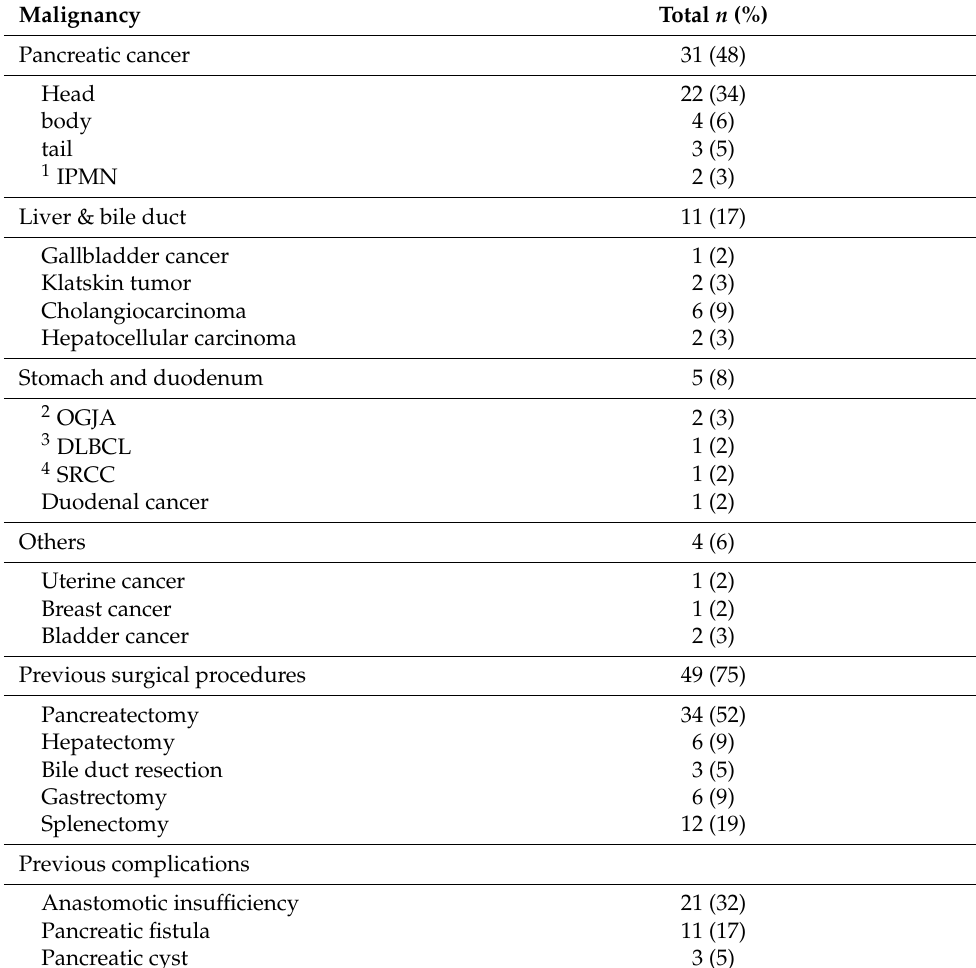
Table 2. Malignancies, surgical procedures, and surgical complications. All percentages are calculated from the whole patient’s cohort n =